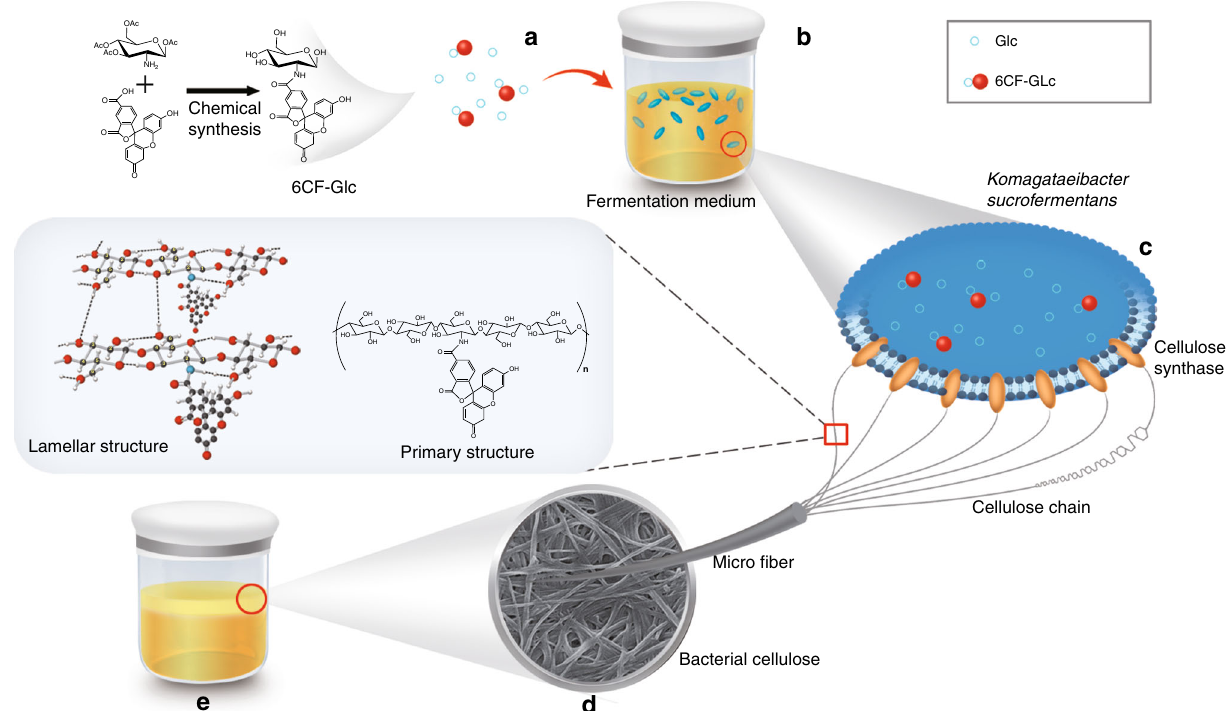
Fig. 6 Synthesis of 6CF-BC based on an in situ microbial fermentation method. Glucose (Glc) was modi fi ed with 6CF, and the 6CF-Glc was used as a carbon source for K. sucrofermentans fermentation to obtain 6CF-BC through microbial metabolic pathways. a Glc and 6CF-Glc molecules. b Microorganism fermentation. c The synthesis of 6CF-BC fi bers through K. sucrofermentans . d Microstructure of 6CF-BC. e The 6CF-BC pellicle obtained through microorganism